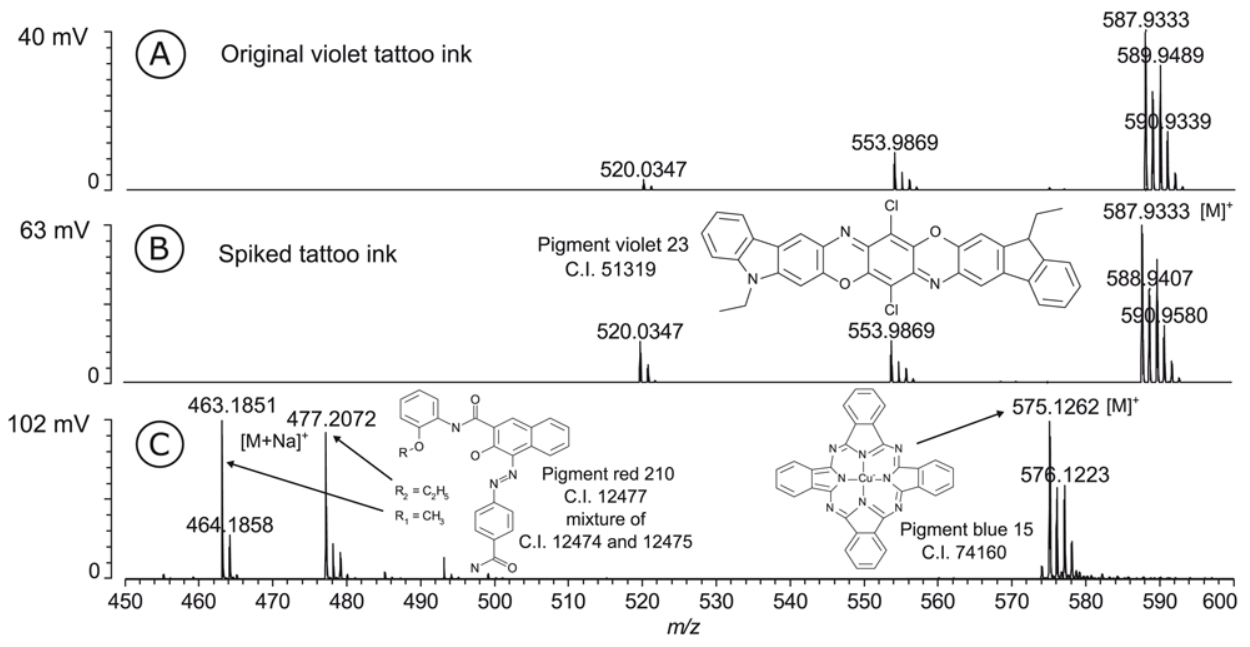
Figure 3. Verification of the prohibited violet pigment C.I. 51319 in a tattoo ink sample by high resolution mass spectra ( A ) and standard addition ( B ), as well as the exclusion of a legal red (C.I. 12477) and blue (C.I. 74160) reference pigment ( C ) in the sample.